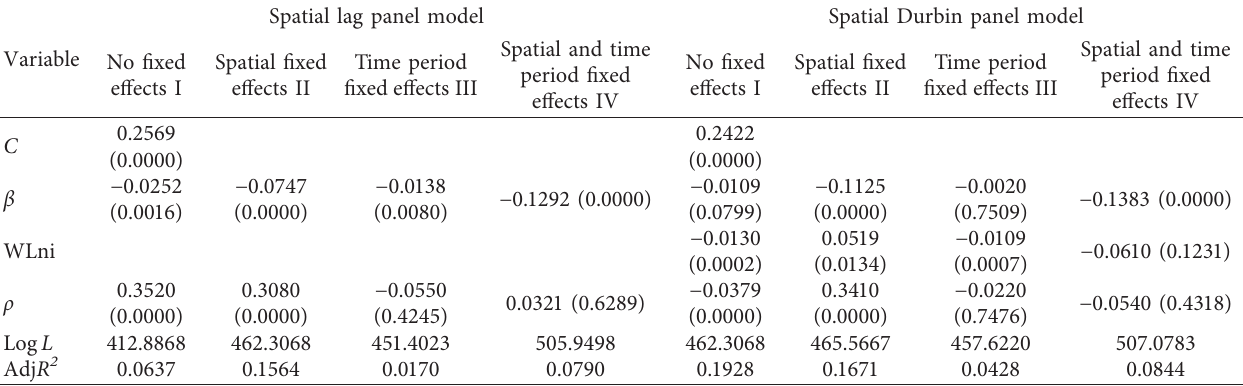
Table 3: Spatial econometric model estimate